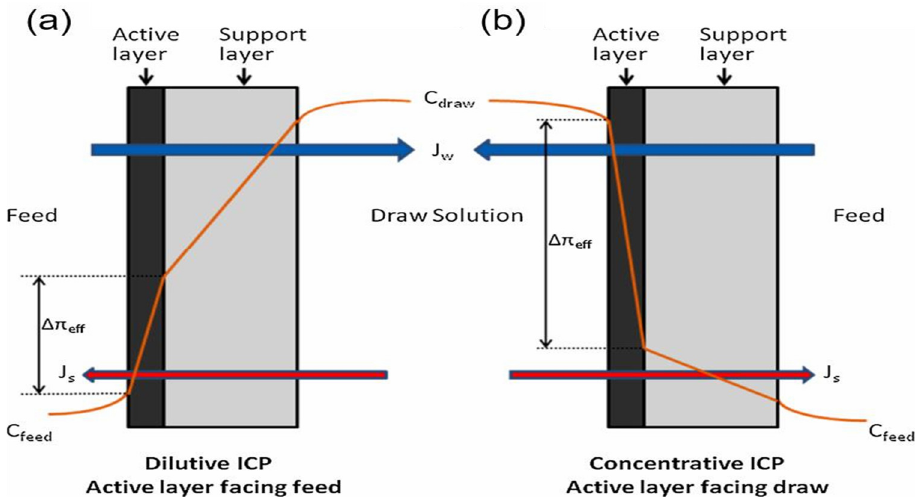
Figure 9. Dilutive and concentration internal polarisation concentration. Reprinted figure with permission from [93]. Copyright (2019) Elsevier.